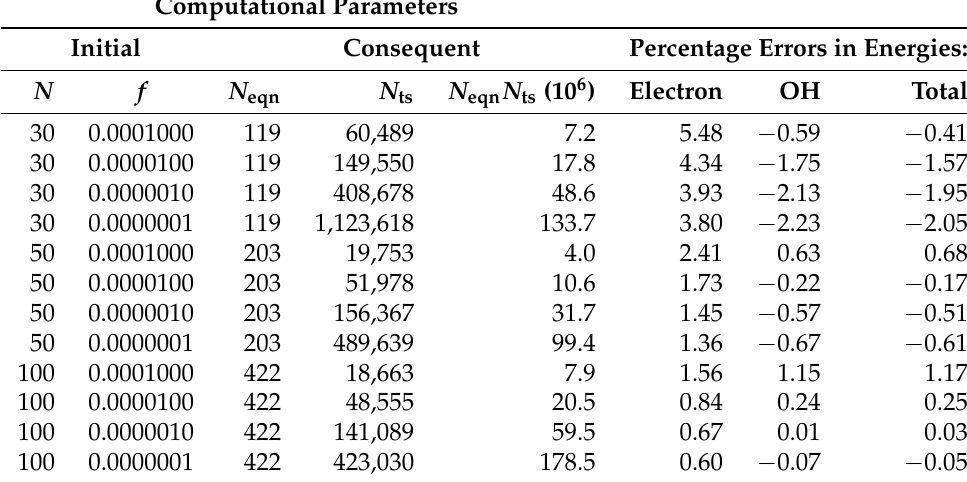
Table 1. Summary of consequent computational parameters (number of rate equations N eqn , number of time steps N ts and their product) and percentage errors in the calculated values (of electron energy, OH energy and total energy) resulting from combinations of the initial computational parameters (maximum subrange N and scaling fraction f ).